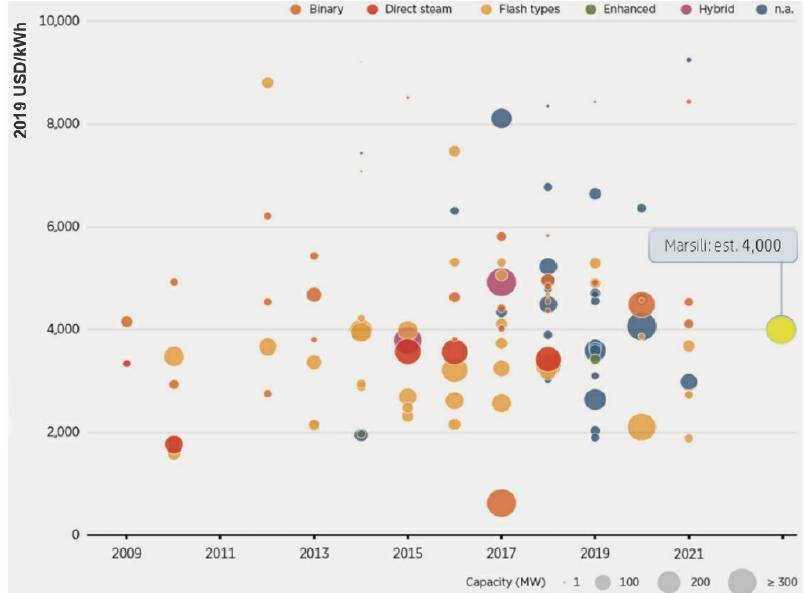
Figure 5. Geothermal power total installed costs by project, technology, and capacity (redrawn from [81]). Marsili is among the medium–high values, value estimated in 4000 USDkW − 1 (the circle filled in yellow).